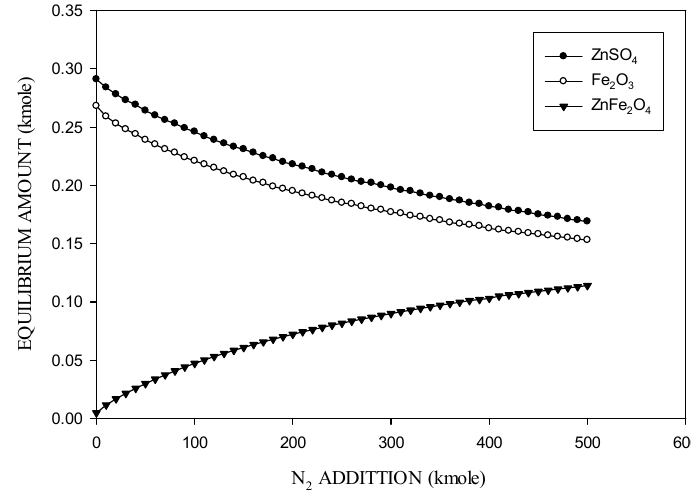
Figure 10. Effect of nitrogen additions on the equilibrium amounts of zinc sulphate, hematite and zinc ferrite.